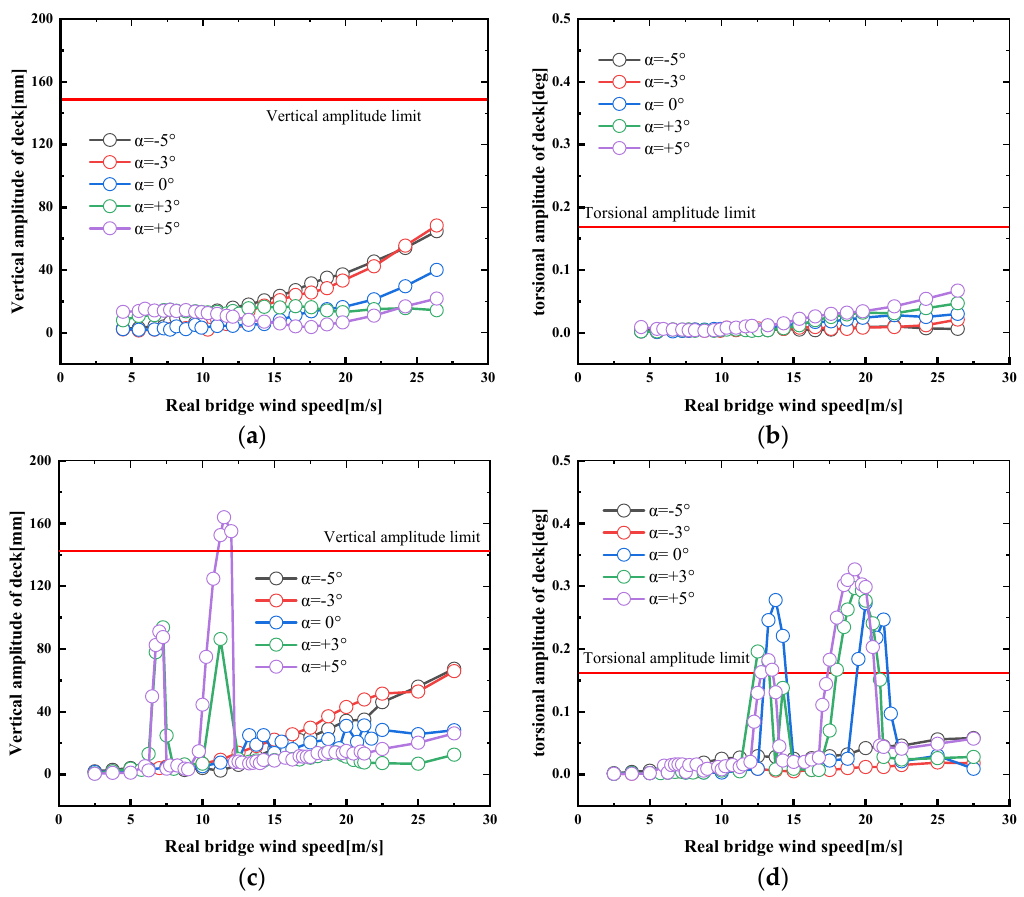
Figure 9. Vertical and torsional response. ( a ) Vertical amplitude of construction; ( b ) torsional amplitude of construction; ( c ) vertical amplitude of service; ( d ) torsional amplitude of service.